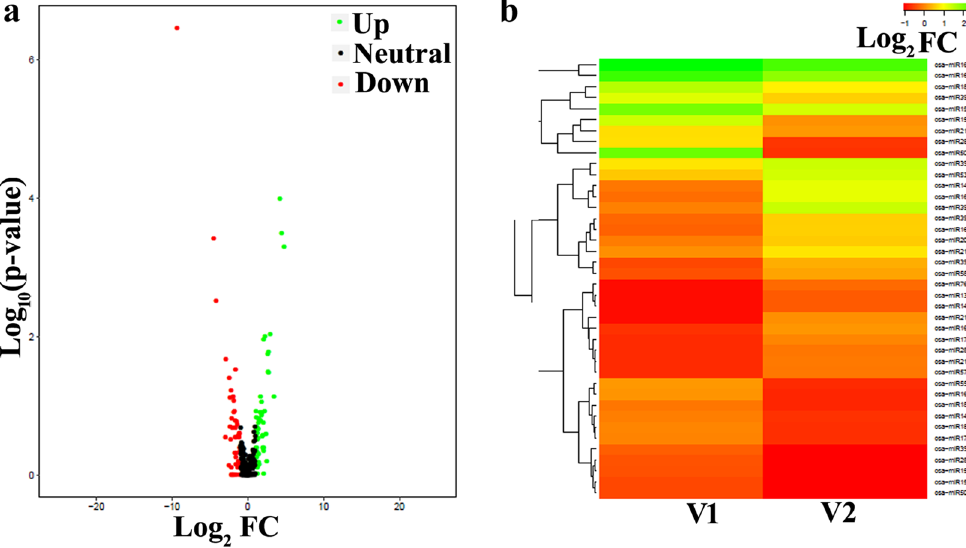
Figure 4. Differential gene expression of miRNAs in 12 samples of V1 (SR-159) and V2 (SR-157) where Log 2 fold change of 1 was used as cut-off. The miRNAs expression in V1 and V2 are either “UP-regulated (green colour code)” or “DOWN-regulated (red colour code)” in comparison to NEUTRAL-miRNA (black-colour code) represented in scatter plot ( a ) and heat map ( b